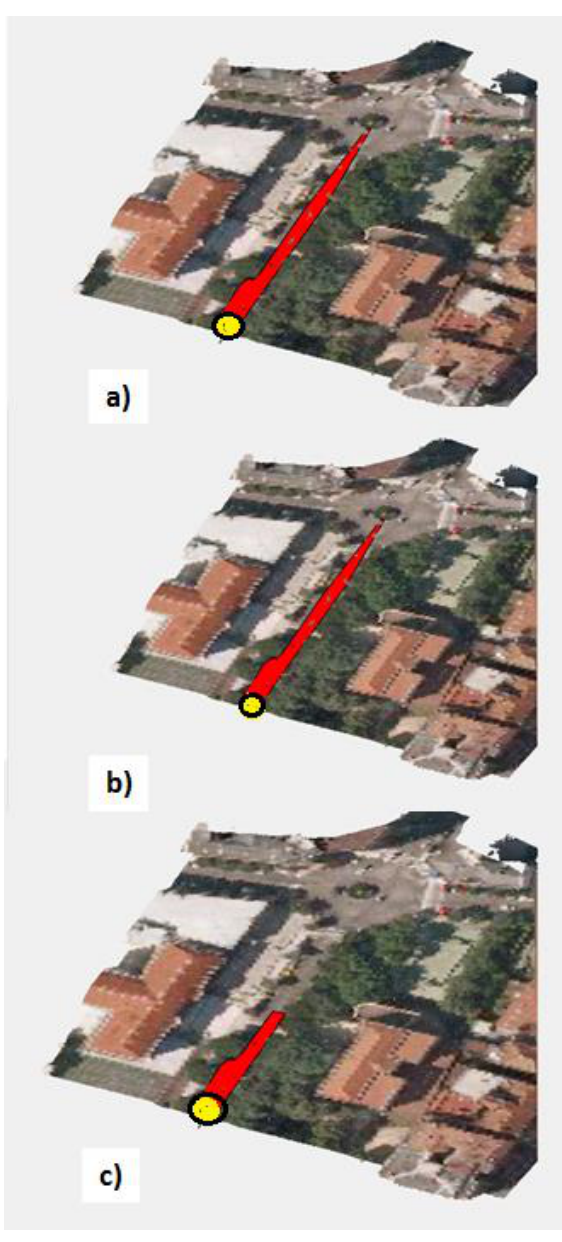
Figure 10. Case study 1. Visibility diagram in the urban road in Vigo. Yellow circle indicates the car position. Visibility range: a) 150 m (fog), b) 100 m (dense fog), and c) 50 m (ultra dense fog).